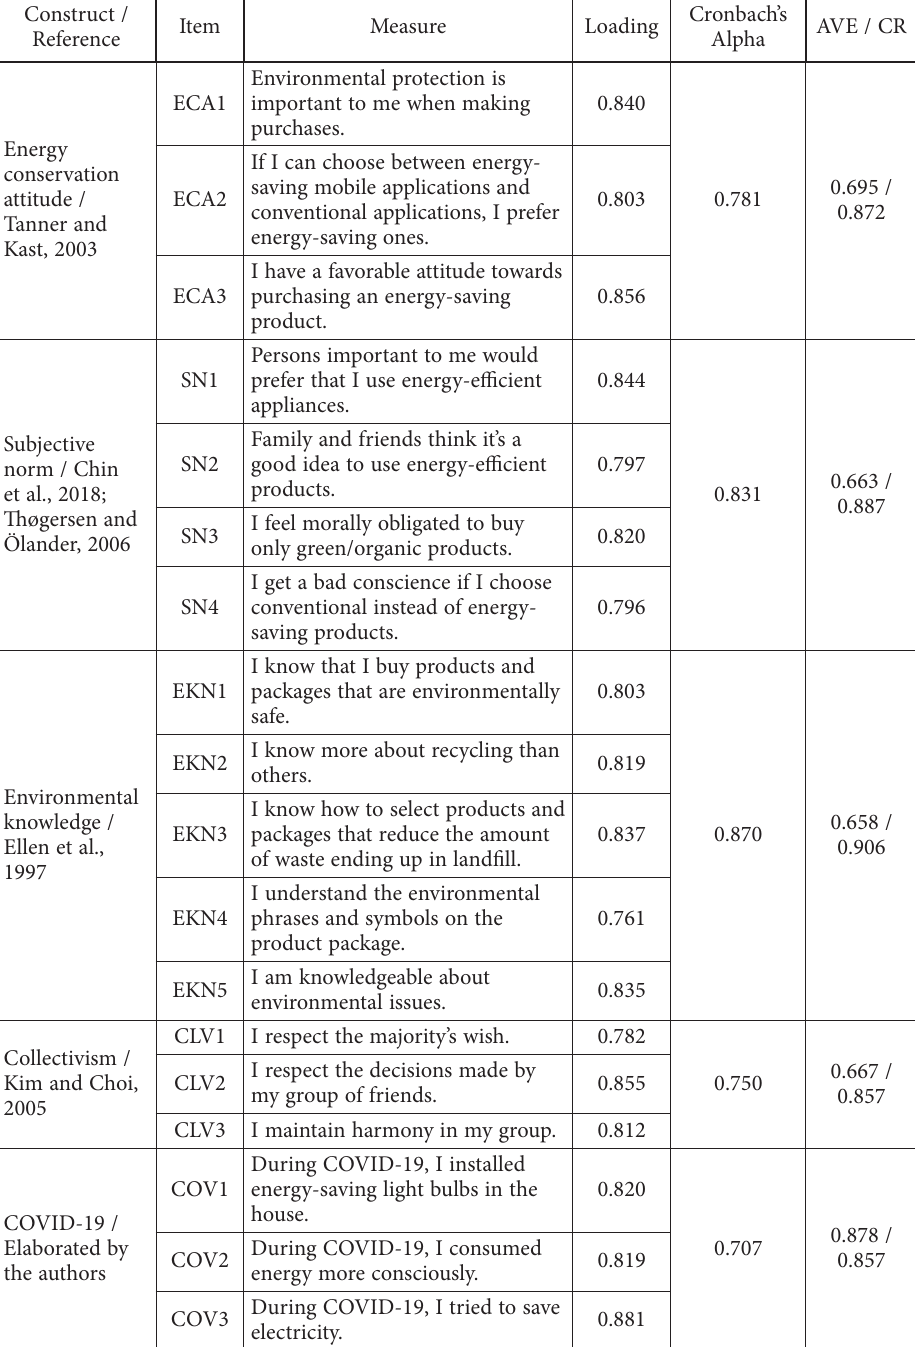
Table 2. Conceptualization of the independent and dependent variables Construct /